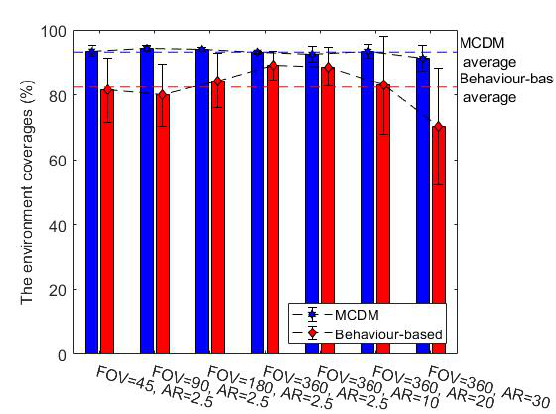
Figure 8. The obstacle map coverage percentages for the environment B, average over ten